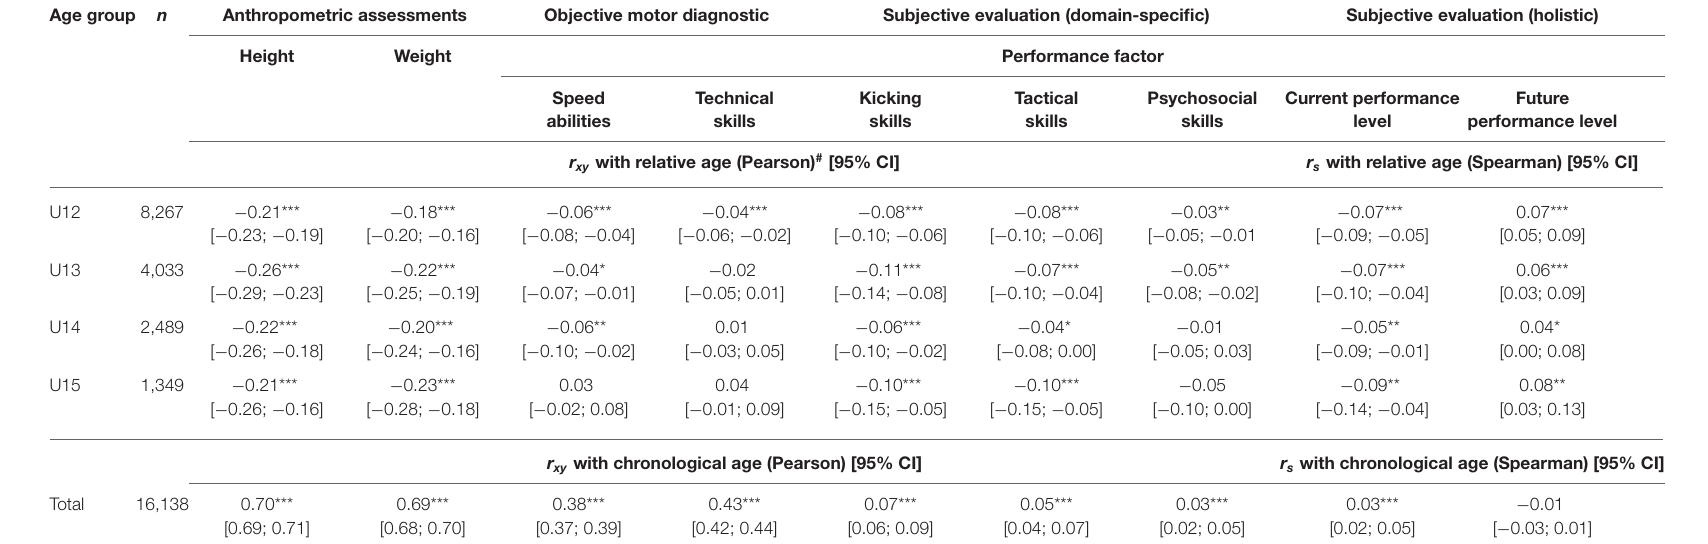
TABLE 3 | Correlations ( r xy ) between players’ relative age (in weeks) and anthropometric data, objectively as well as subjectively assessed domain-specific performance factors separated by age group. Age group